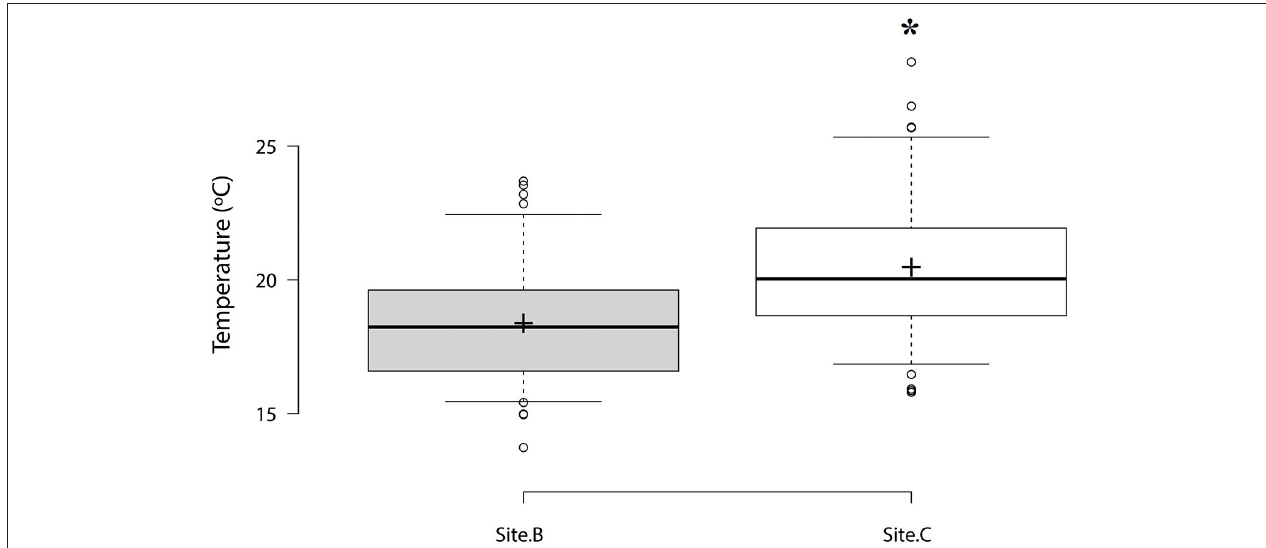
FIGURE 2 | Box plot of maximum temperatures per day at Site B and Site C. Center lines show the median, box limits indicate the 1st and 3rd quartile. Sample means are represented by crosses. Significant differences are designated with an asterisk ( n = 73, p ≤ 0.05).